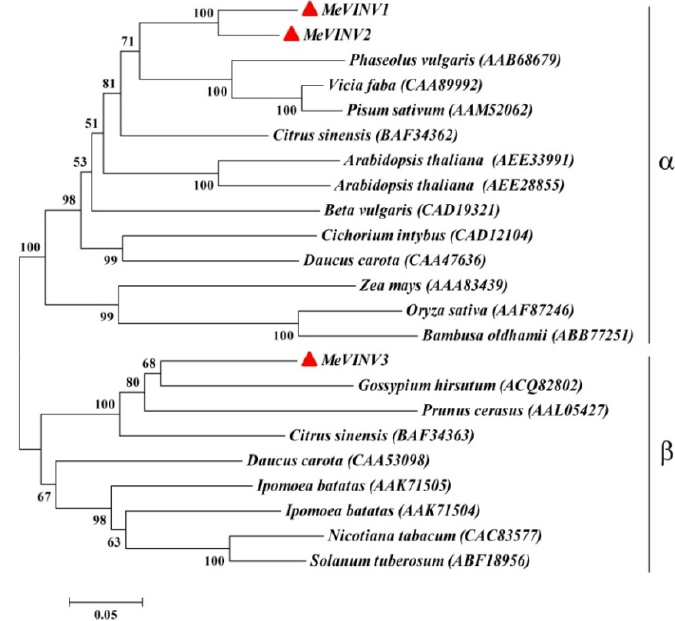
Figure 5. Phylogenetic relationship of the cassava vacuolar invertase amino acid sequences with amino acid sequences from fifteen species. The analysis was performed using the MEGA 5.2 program. The phylogenetic tree was constructed using the neighbor-joining method and bootstrapped 1000 times. The scale bar indicates the evolutionary distance between the groups. MeVINVs are shown in red triangles.